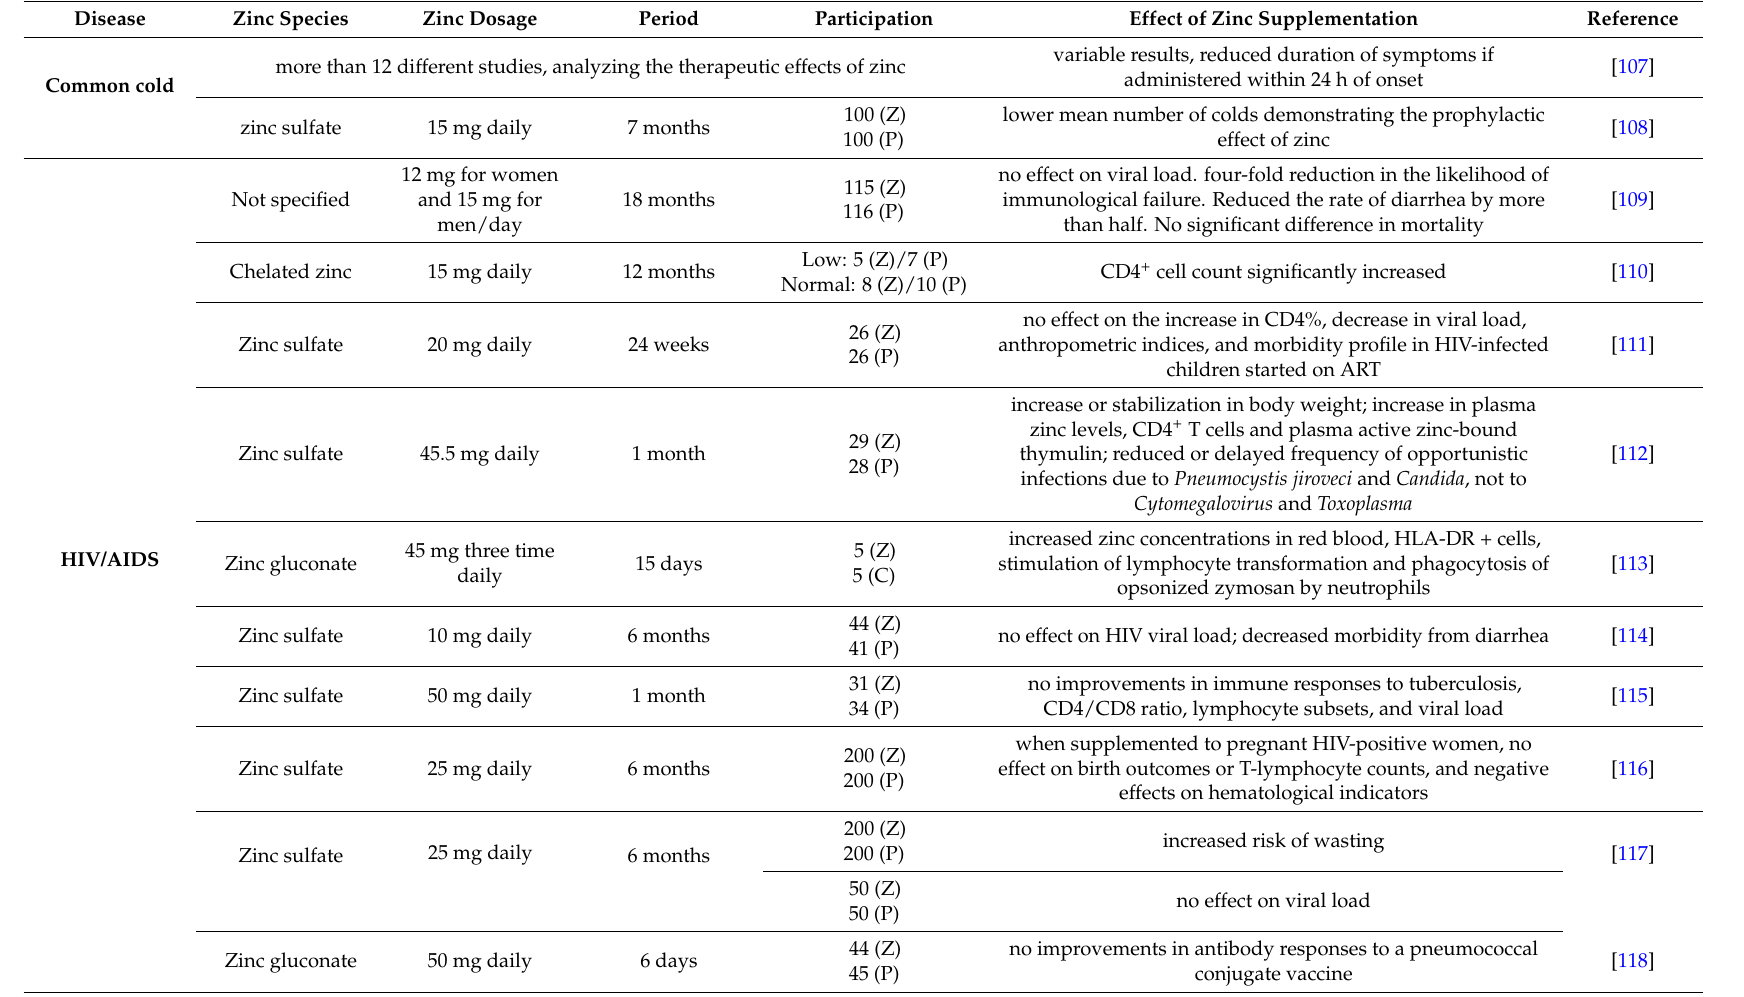
Table 1. Zinc supplementation and viral diseases (updated from